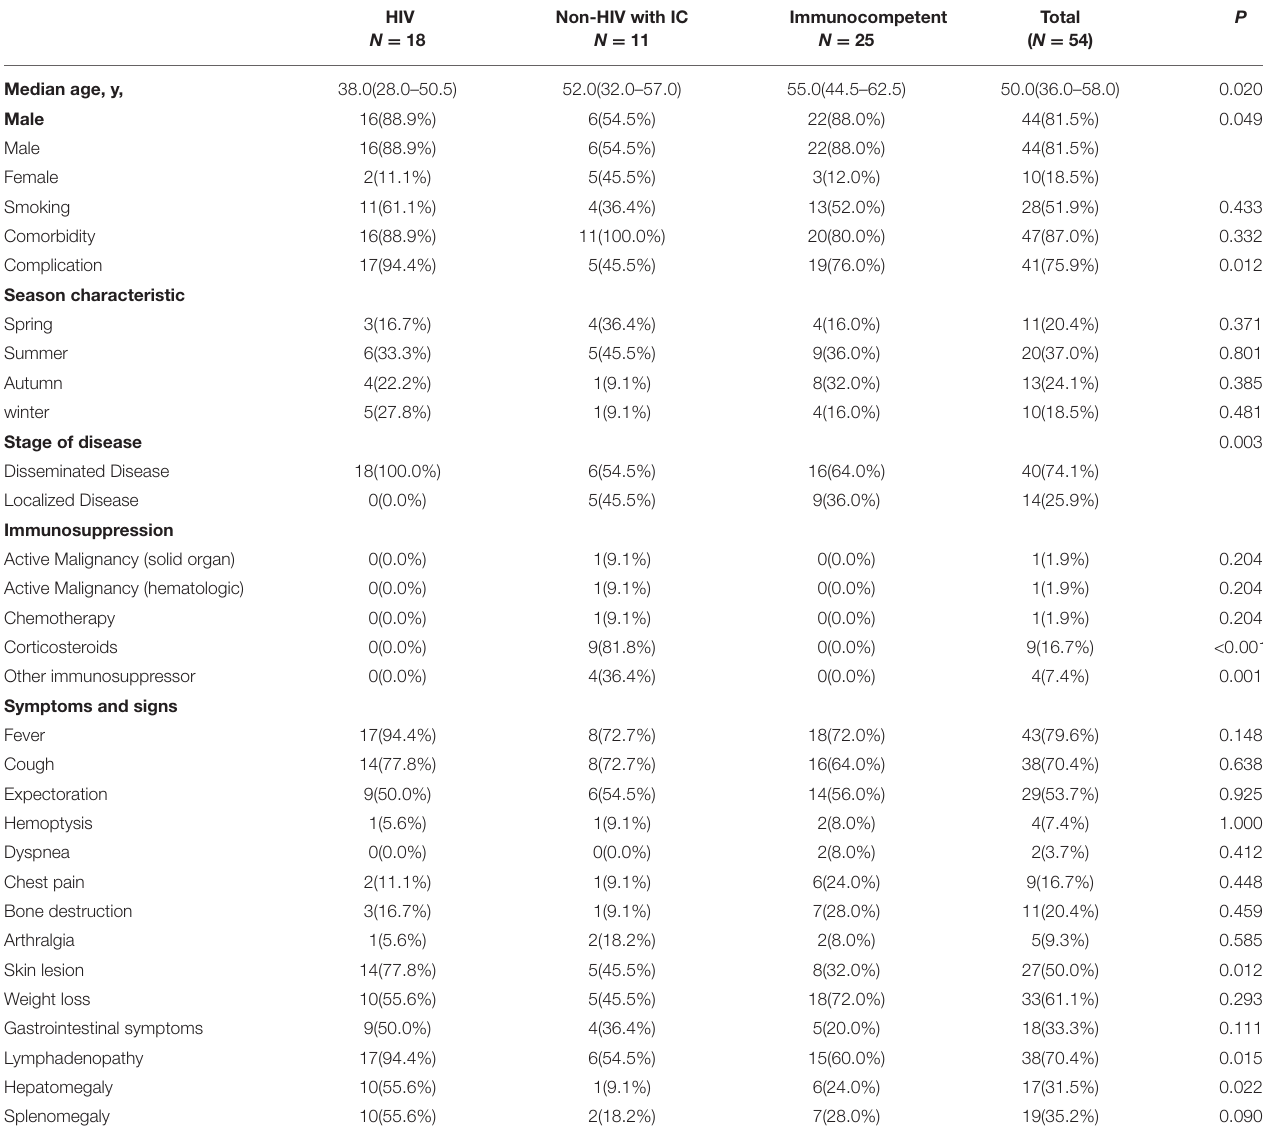
TABLE 1 | Clinical characteristics of the patients with TM infection across the three